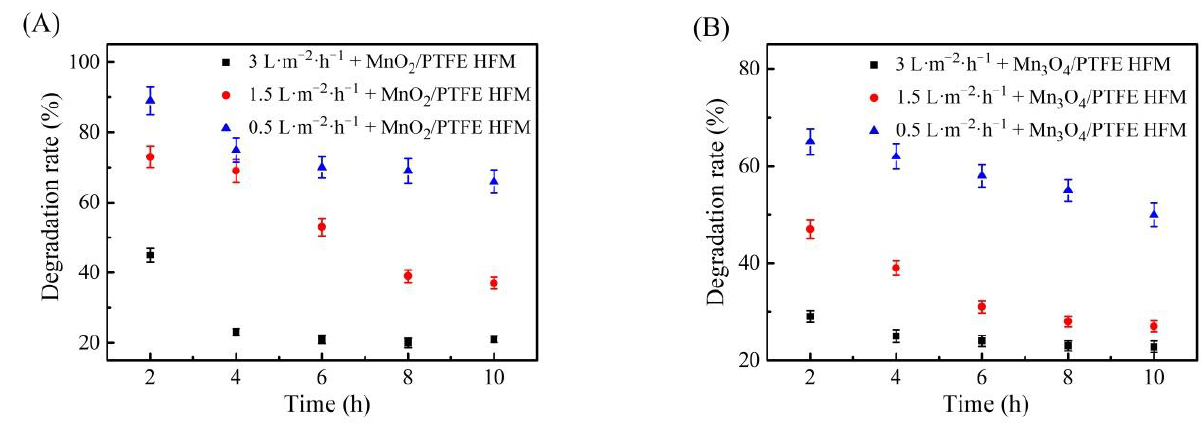
Figure 12. The influence of flux on the degradation of phenol: ( A ) used MnO 2 /PTFE HFM; ( B ) Mn 3 O 4 /PTFE HFM.